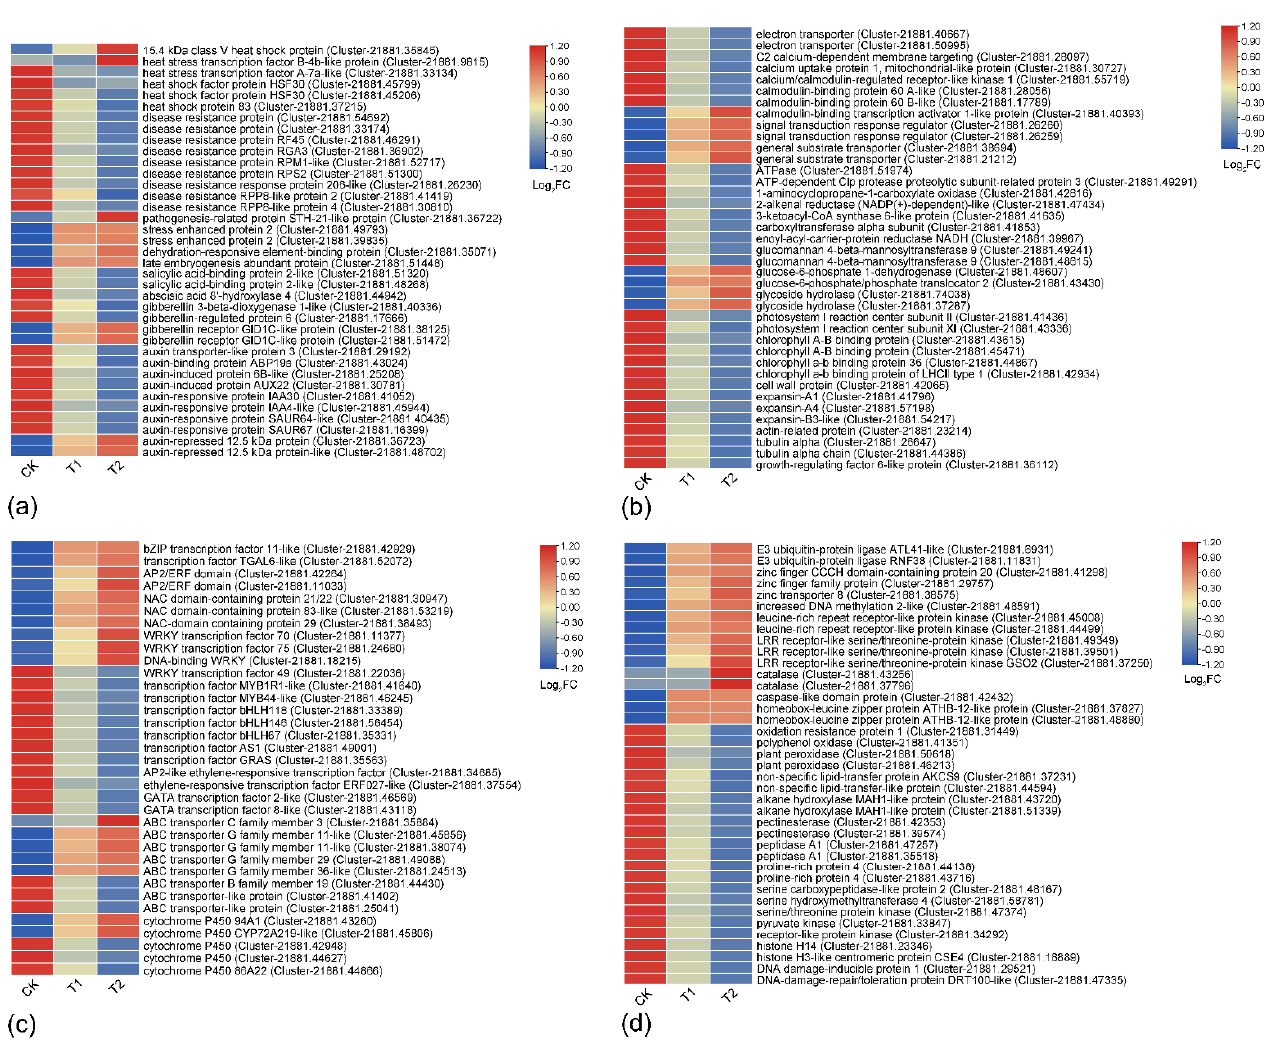
Figure 7. Heatmap of the DEGs associated with heat response in Michelia macclurei . Red means up-regulation, and blue means down-regulation. (a) The genes that code heat shock proteins, disease resistance proteins, stress enhanced proteins, and hormone synthesis. (b) The genes related to signal transduction, energy metabolism, photosynthesis, and cell elongation; (c) Main transcription factors, ABC transporters, and cytochrome; (d) The genes related to oxidation reduction and heat stress resposne.